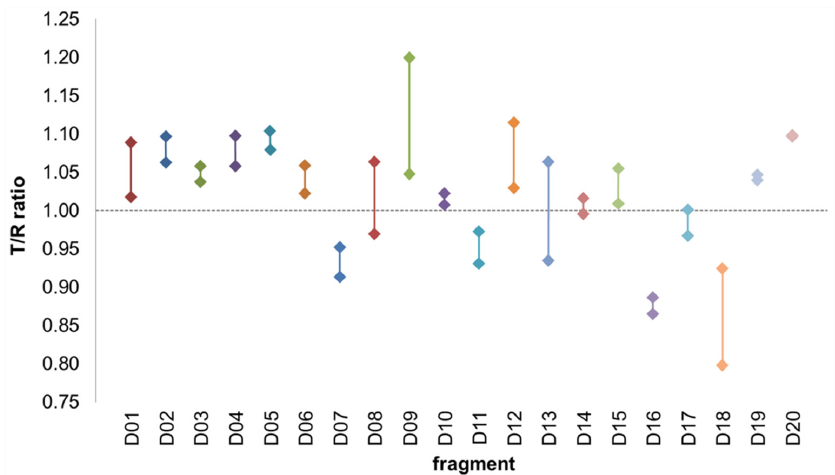
Figure 4. Sensitivity and reproducibility. As quality control, twenty fragments were run in duplicate. The median difference between two measurements was 0.04 and the average difference was 0.05. This shows that the sensitivity of the method is high enough to justify the chosen cutoff of T/R ≤ 0.85. Sixteen out of these twenty fragments had the same outcome, favoring either FtsQ p (T/R < 1.00) or the reference protein (T/R > 1.00) in both experiments. Two fragments had a different outcome but a very small mutual difference < 0.05 close to T/R = 1 (D14 and D17), and two fragments did have a different outcome due to a mutual difference > 0.05 (D13 and D08). Int. J. Mol. Sci. 2019 , 20 , x FOR PEER REVIEW